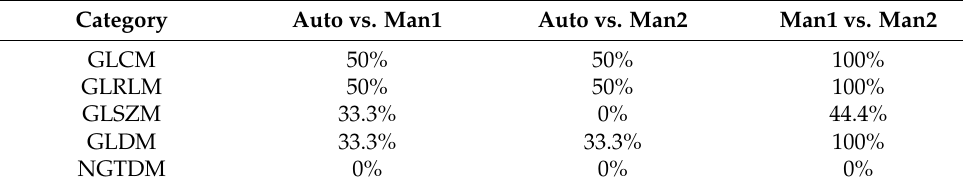
Table 5. Percentage of features with robustness index ≥ 3. Category Auto vs. Man1 Auto vs.